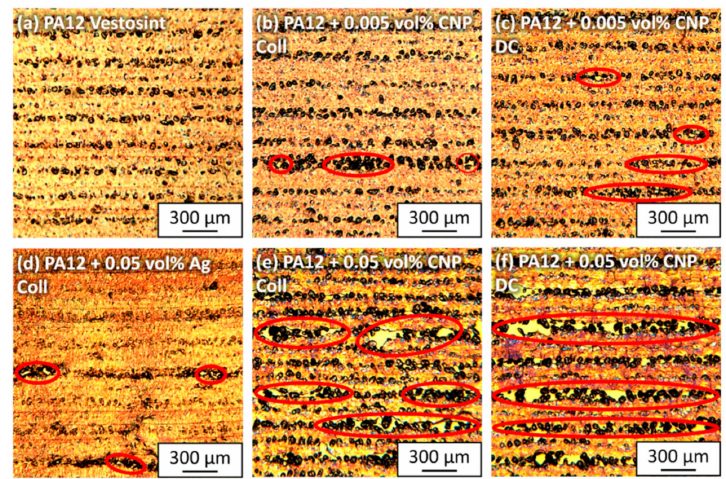
Figure 4. Microscopic polarized images of 10 µ m sliced LB-PBF-P specimens made of ( a ) pure PA12, ( b , c ) PA12 and 0.005 vol% carbon nanoparticles, ( d ) PA12 and 0.05 vol% silver nanoparticles, and ( e , f ) PA12 and 0.05 vol% carbon nanoparticles. PA12 powders were additivated ( b , d , e ) with the colloidal deposition and ( c , f ) with the dry coating method. The images provide an overview of the processed layers in a horizontal position, where higher amounts of carbon nanoparticles lead to poorer layer